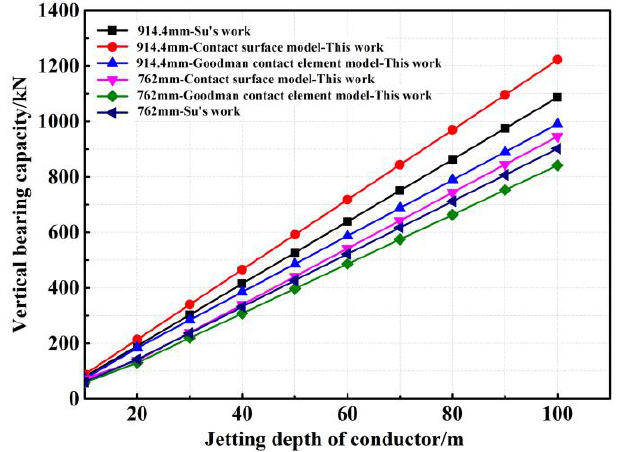
Figure 11. Model verification results.